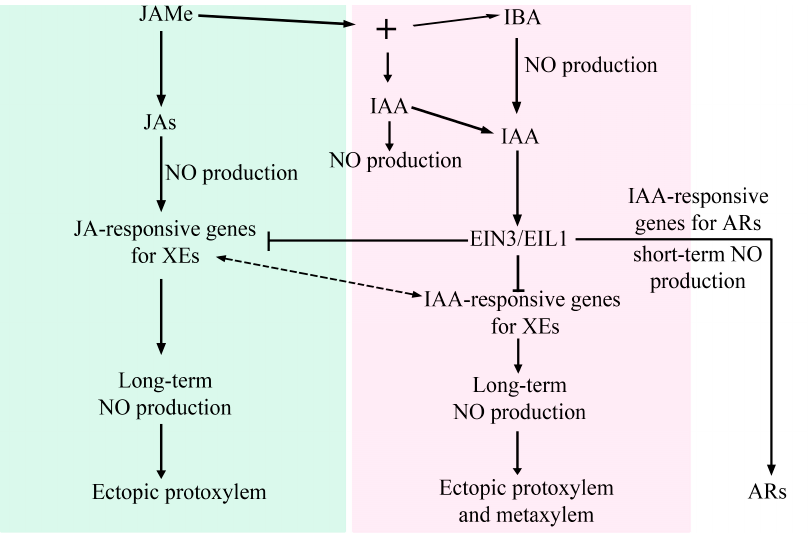
Figure 9. Proposed model for jasmonates (JAs) and auxin (IAA/IBA) roles in the formation of ectopic xylary cells (XEs) in the pericycle derivative cells of Arabidopsis basal hypocotyl of seedlings cultured with JAMe (10 μ M) +/ − IBA (10 μ M) or IAA (10 μ M). The pathway leading to the formation of